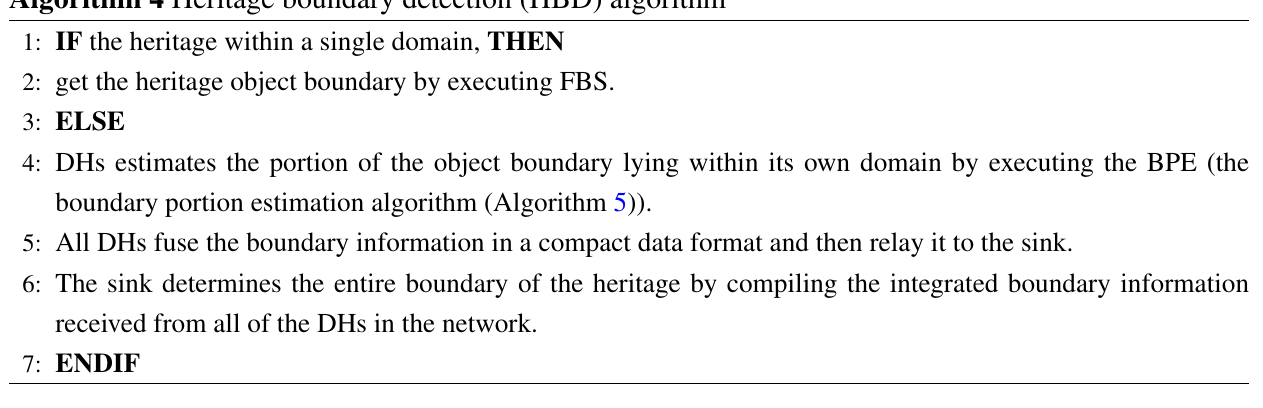
Algorithm 4 Heritage boundary detection (HBD) algorithm